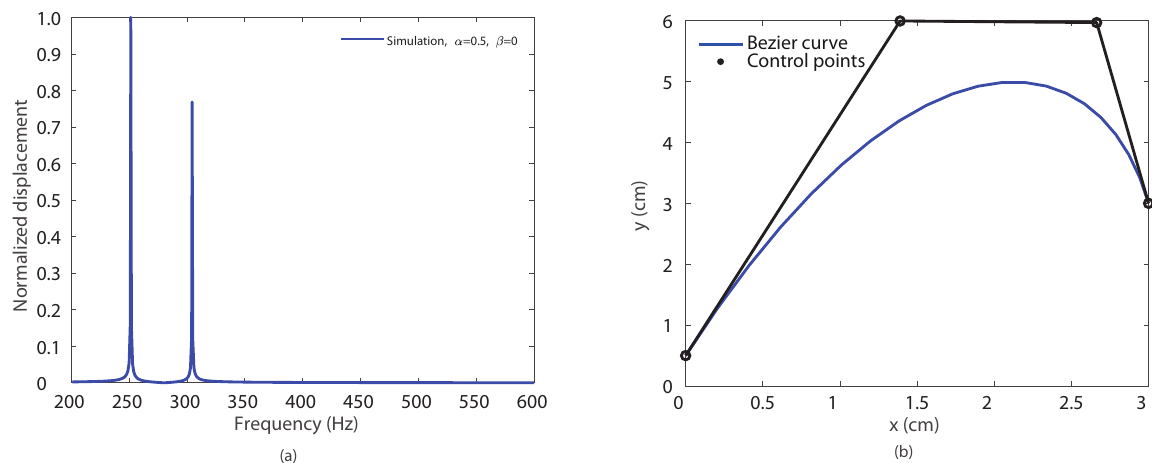
Figure 14. Normalized frequency response function for S = 1.2 ( a ), and the profile of an optimized Bézier plate for S = 1.2 ( b ). In order to understand the effects of the geometric parameters of the device for the frequency ratio f 2 / f 1 and the vibration amplitude ratio U 1 / U 2 , a parametric study was carried out based on the optimized case, as shown in Figure 14. First, various cases with different lengths of the longer edge B were considered. Figure 15 shows the profiles of these cases. Figure 16a shows the values of f 2 / f 1 and U 1 / U 2 as functions of B ; f 2 / f 1 and U 1 / U 2 increased as B increased for the values of B ranging from 2 cm to 10 cm. Figure 16b shows f 2 / f 1 and U 1 / U 2 as functions of the thickness T with a profile the same as that of the optimized case in Figure 14b; f 2 / f 1 and U 1 / U 2 decreased as T increased from 0.04 cm to 0.14 cm. As the plate with the geometric parameters was perturbed by an optimized solution, a range of solutions with various f 2 / f 1 and U 1 / U 2 values can be found to fulfill the design requirements without resorting to the optimization design procedure if an optimized solution is not required.